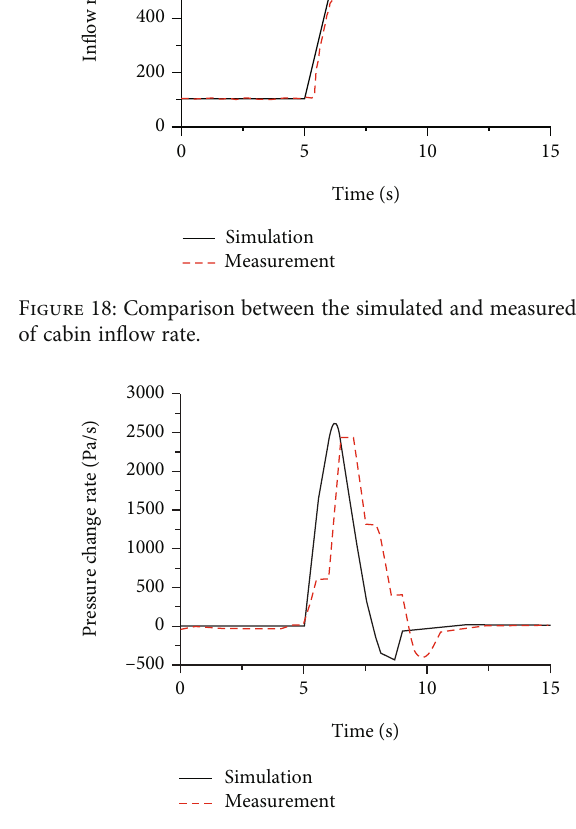
Figure 19: Comparison between the simulated and measured data of cabin pressure change